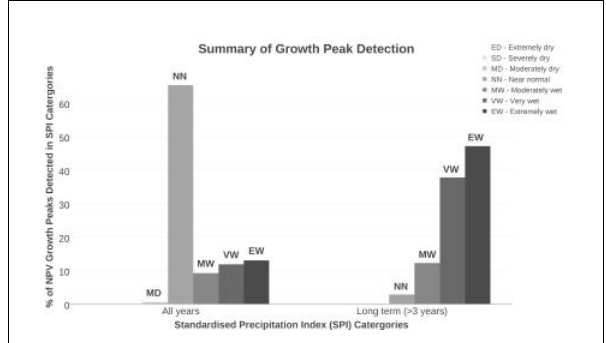
Figure 12. Results of NPV growth peak assessment. All